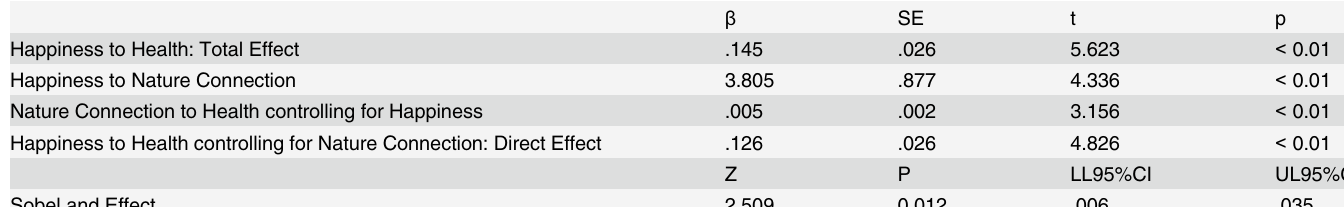
Table 4. Simple Mediation of the Indirect Effects of Happiness and Nature Connection on Health (5000 Bootstrap Samples).